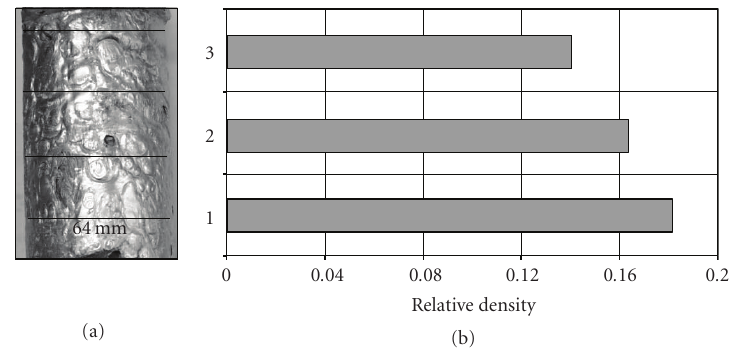
Figure 7: Relative density gradient for the sample SM, N 2 , ambient sectioned in 3 slices.